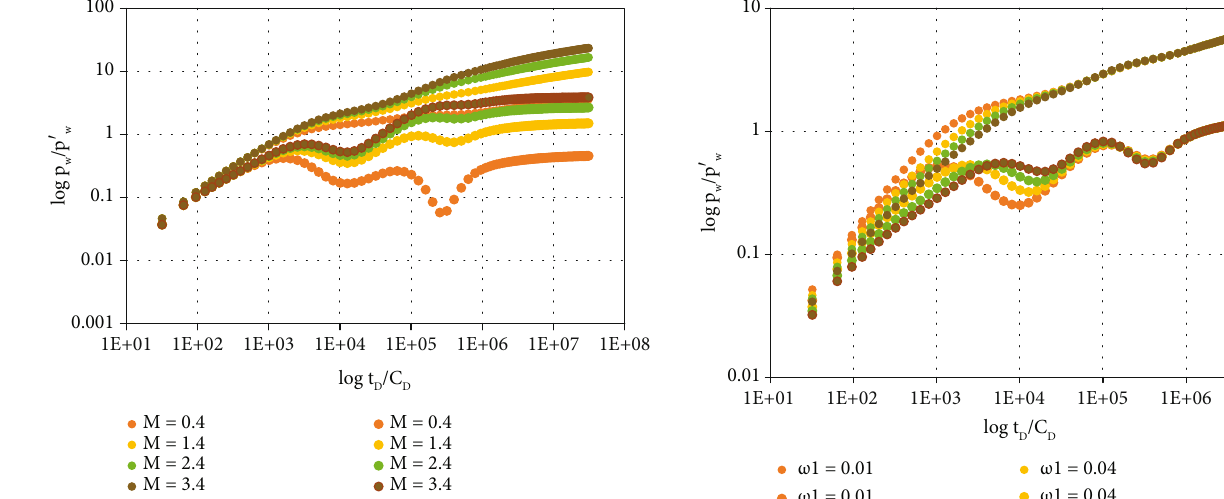
Figure 7: The in fl uence of the elastic storage capacity ratio of the inner zone on pressure di ff erence and pressure di ff erence derivative curve.